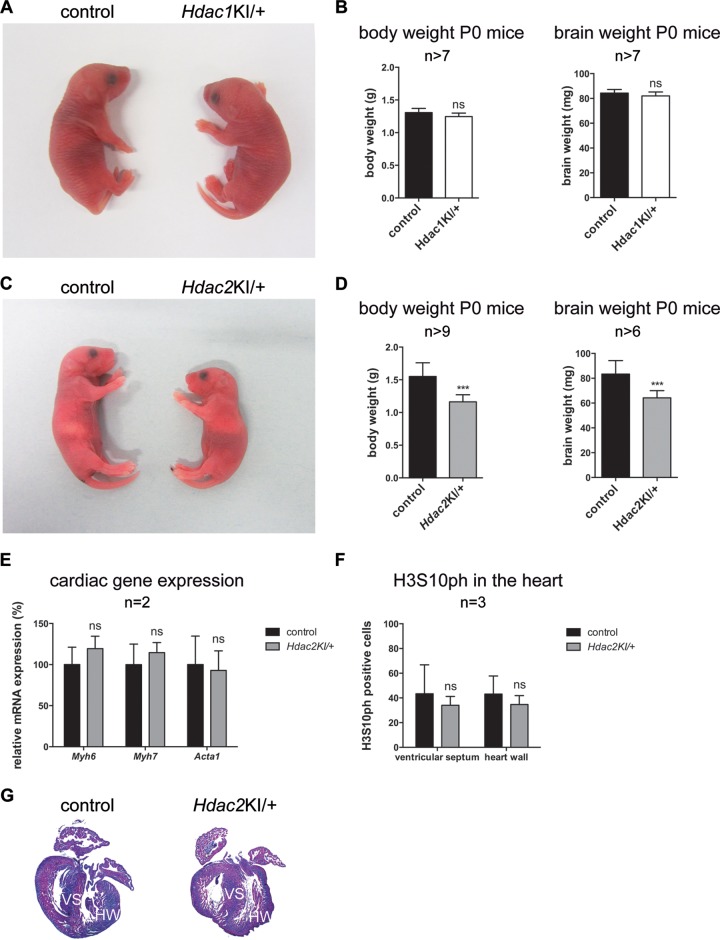
Divergent phenotypes upon heterozygous expression of HDAC1-H141A and HDAC2-H142A. (A) Representative picture of a wild-type newborn mouse (left) versus an Hdac1KI/+ newborn littermate (right). (B) Body and brain weights of P0 control (black) compared to Hdac1KI/+ (white) mice. Error bars indicate SD (n > 7). ns, not significant. (C) Representative pictures of a wild-type newborn mouse (left) versus an Hdac2KI/+ newborn littermate (right). (D) Body and brain weights of P0 control (black) compared to Hdac2KI/+ (gray) mice. Error bars indicate SD (n > 9 [left] and n > 6 [right]). ***, P < 0.001. (E) Relative mRNA expression levels of Myh6, Myh7, and Acta1 in Hdac2KI/+ hearts compared to the corresponding wild-type littermate controls. Values are normalized to the values for the housekeeping gene Gapdh. Error bars indicate SD (n = 2). ns, not significant. (F) H3S10ph-positive cells in the ventricular septum and heart wall in Hdac2KI/+ P0 mice compared to the corresponding wild-type littermate controls. Error bars indicate SD (n = 3). ns, not significant. (G) H&E-stained P0 wild-type control littermate (left) and Hdac2KI/+ (right) paraffin heart sections. HW, heart wall; VS, ventricular septum.